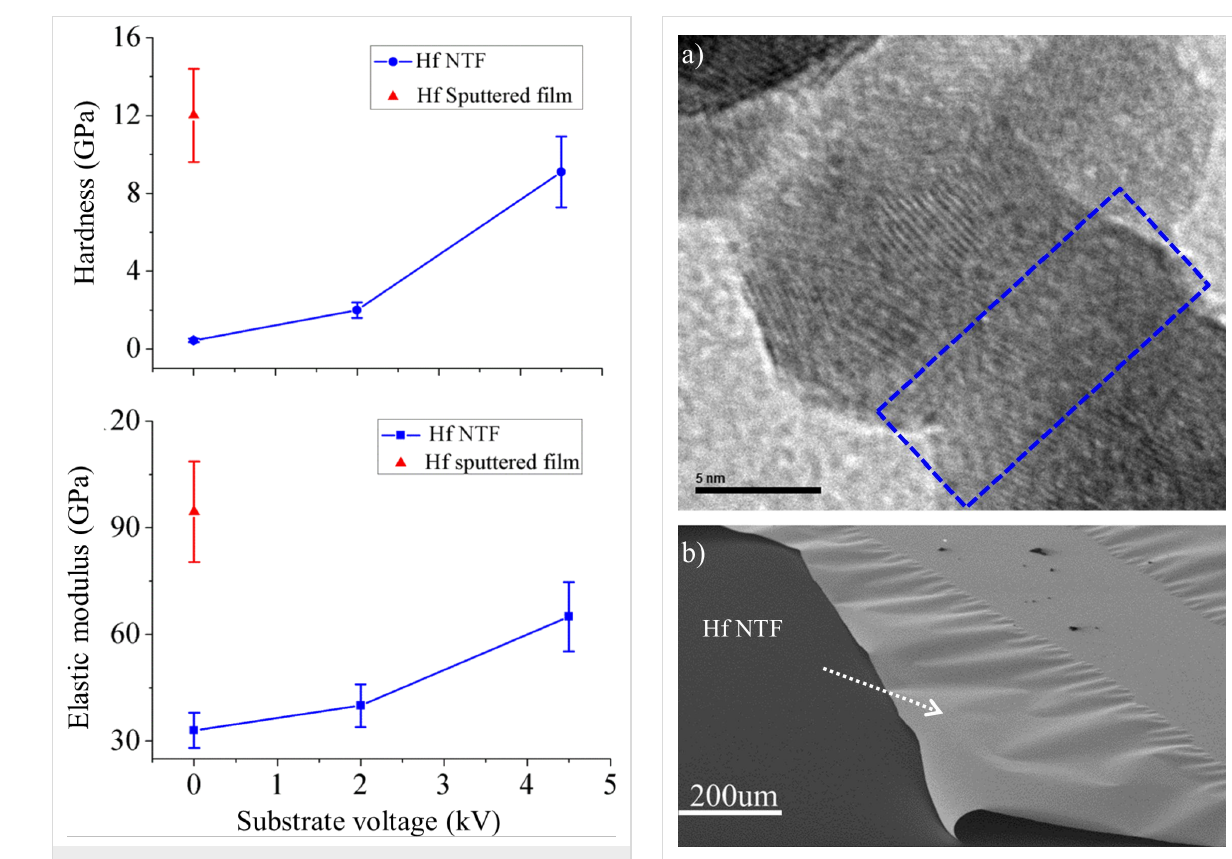
Figure 9: Dependence of hardness ( H ) and elastic modulus ( E ) of Hf NTFs as functions of the substrate voltage V s . Porosity of Hf NTFs